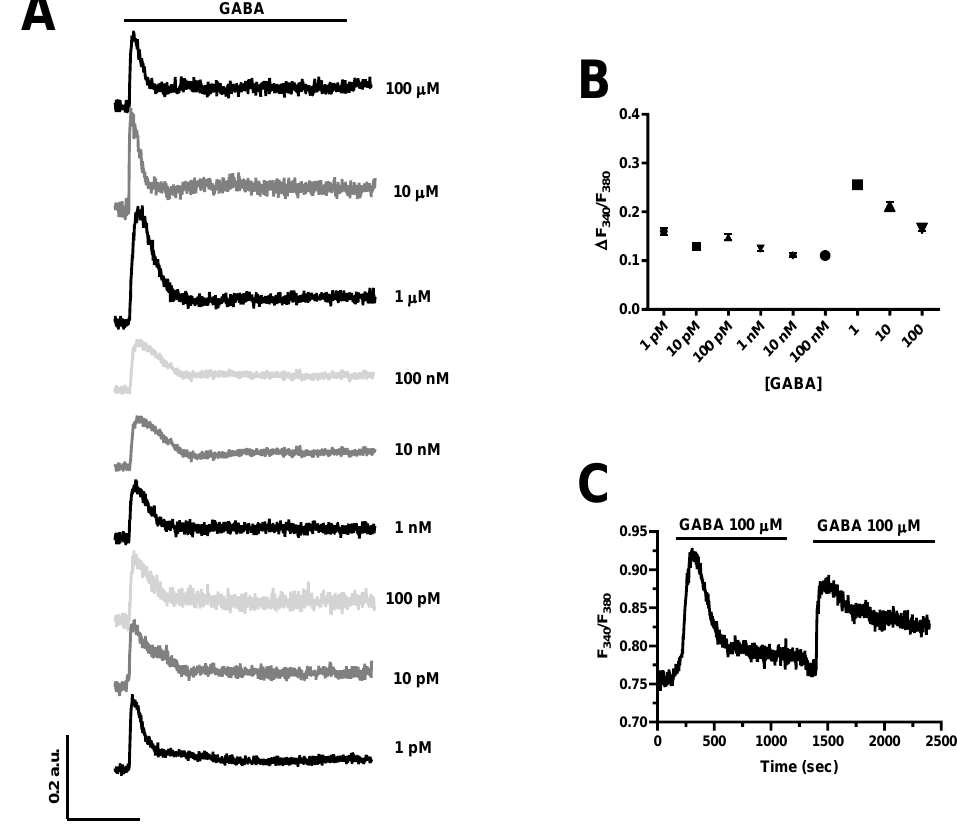
Figure 2. GABA evokes a dose–response increase in [Ca 2+ ] i in hCMEC/D3 cells. ( A ), the inhibitory neurotransmitter, GABA, elicits a dose-dependent elevation in [Ca 2+ ] i , which remains relatively stable between 1 pM and 100 nM and achieves its peak at 1 µ M. In this and the following figures, the black bar above the Ca 2+ tracings indicates the time of agonist addition. ( B ), mean ± SE of the amplitude of the initial Ca 2+ peak evoked by GABA at each agonist concentration ([GABA]). The number of analyzed cells ranges between 103 and 117 from three independent experiments for each dose. ( C ), GABA (100 µ M) elicits an additional increase in [Ca 2+ ] i upon 3 min washout, which indicates that GABA receptors do not desensitize at this agonist concentration.